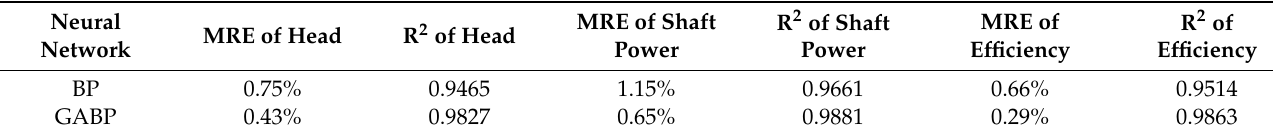
Table 9. Comparison of the MRE and R 2 of fitting.